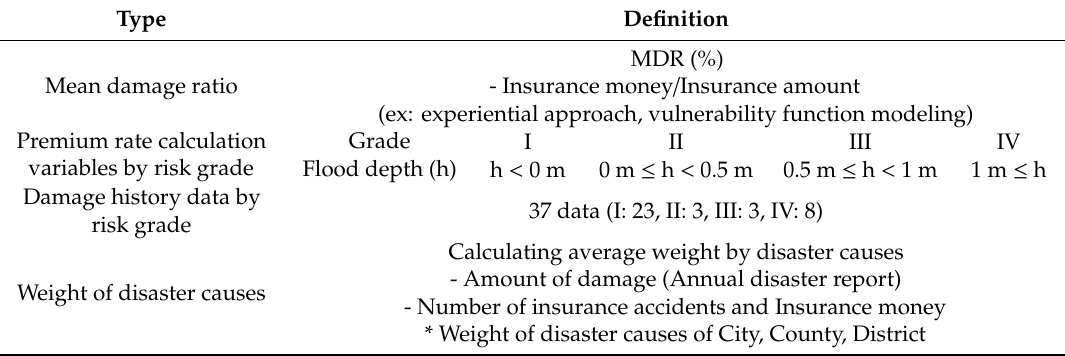
Table 2. Items considered when calculating premium rates.